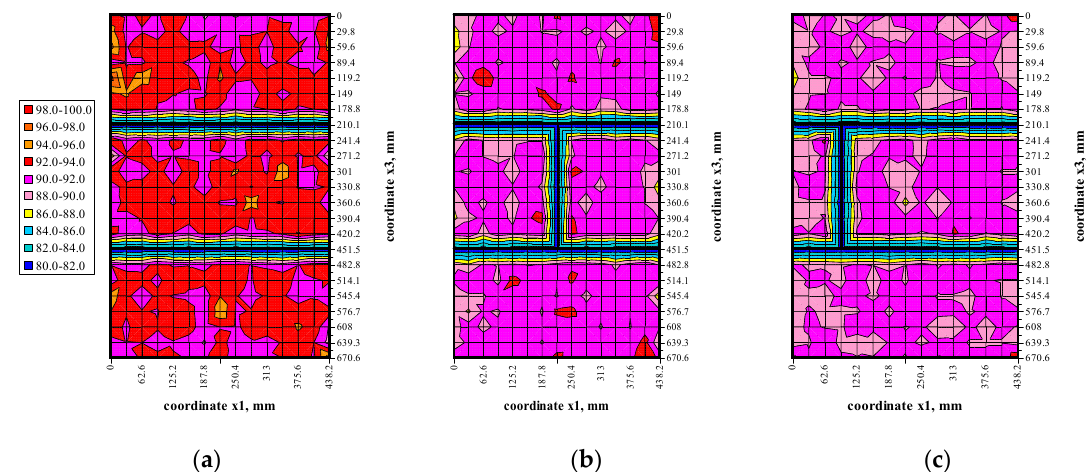
Figure 10. Results from measuring passing time of the ultrasonic wave under the load σ 3 = 0: ( a ) model I-1, ( b ) model II-1, ( c ) model III-1.